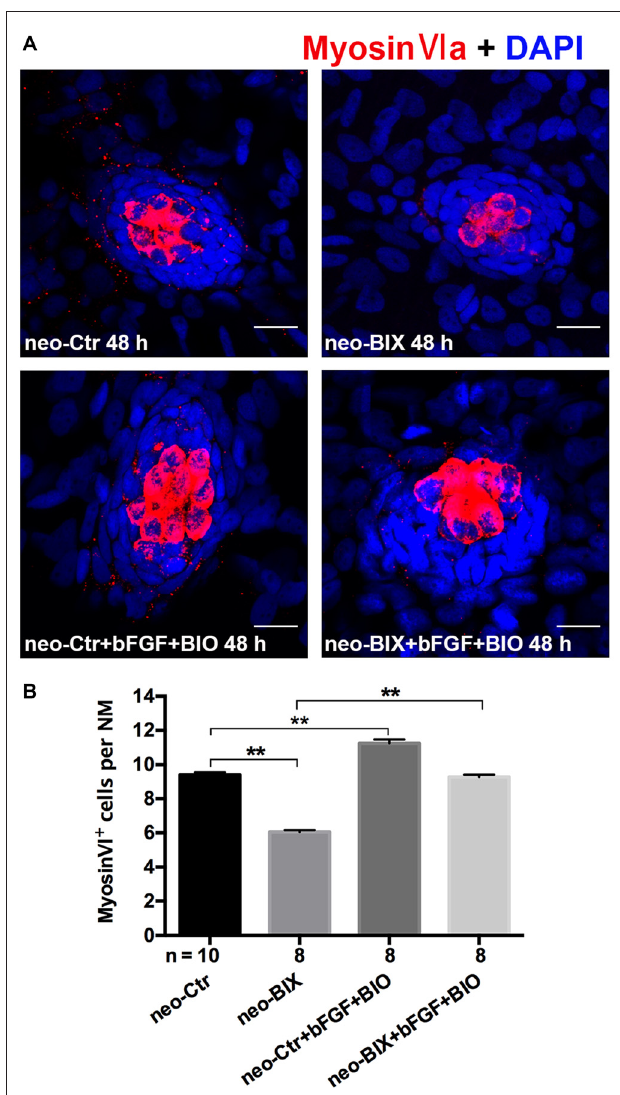
FIGURE 7 | The decreased HC regeneration after BIX01294 treatment following neomycin damage can be recued with the addition of bFGF and OF 6-bromoindirubin-3-oxime (BIO). (A) Co-treatment of bFGF and BIO with BIX01294 after neomycin damage increases the number of HCs (Myosin-VI + , red) compared to the BIX01294-only treatment. Nuclei are stained with DAPI. Scale bars = 10 µ m. (B) The average number of Myosin-VI + cells per NM in larvae treated with or without BIX01294 for 48 h after neomycin damage for 1 h and the average number of Myosin-VI + cells per NM after the addition of bFGF and BIO to controls or BIX01294-treated larvae. Bars are mean ± SEM, and n = total number of embryos. ∗∗ p <